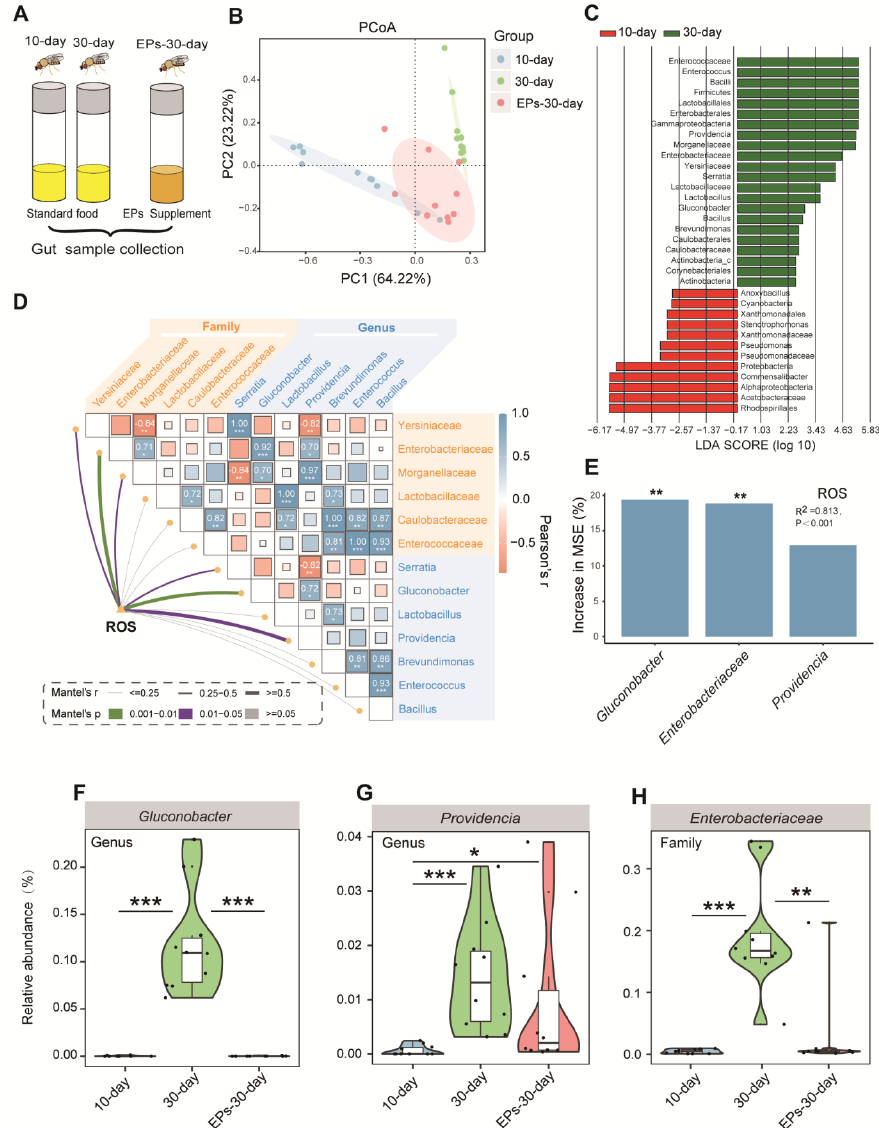
Figure 5. EPs remodeled the gut microbiota of aged Drosophila. ( A ) Schematic diagram of the experimental procedure (10-day- and 30-day-old flies in the control group and 30-day-old flies in the EP groups, 15 males and 15 females per sample, n = 10). ( B ) ASV-based PCoA with the Bray–Curtis distance (for principal component 1 and principal component 2), showing the variations of the gut microbial beta diversity of 10-day- and 30-day-old flies in the control group and 30-day-old flies in the EP groups and assessed with permutational multivariate analysis of variance (PERMANOVA). ( C ) Discriminative taxa between the 10-day- and 30-day-old flies (log 10 LDA > 2) determined by LEfSe. ( D ) Correlations between ROS accumulation and microbial diversity of flies are shown, with a color gradient denoting Spearman’s correlation coefficient. The ROS level was related to microbial diversity using partial Mantel tests. The edge width corresponds to the Mantel’s r statistic for the corresponding distance correlations, and the edge color denotes the statistical significance based on 999 permutations. ( E ) RF mean predictor importance (percentage of increase in mean square error) of dominant phyla (>5% of total community) as drivers for ROS accumulation in old flies. Percentage increases in the MSE (mean square error) of variables were used to estimate the importance of these predictors, and higher MSE% values imply more important predictors. ( F – H ) Comparison of the proportions of Gluconobacter ( F ), Providencia ( G ), and Enterobacteriaceae ( H ) in the gut microbiota detected using 16S sequencing analysis. Significance levels are as follows: * p < 0.05, ** p < 0.01, *** p <